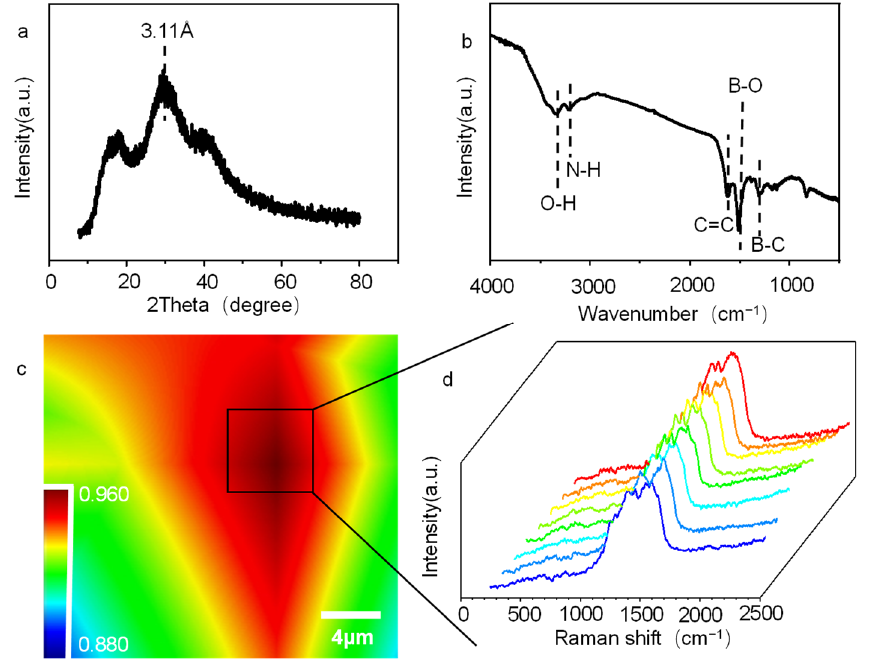
Figure 3. ( a ) XRD patterns of o-GQDs, ( b ) FT-IR patterns of o-GQDs, ( c ) High resolution microscope Raman image of c-GQDS (color indicates the ratio of peaks D to G), and ( d ) Typical Raman spectra in the box region of Figure 3d. the box region of Figure